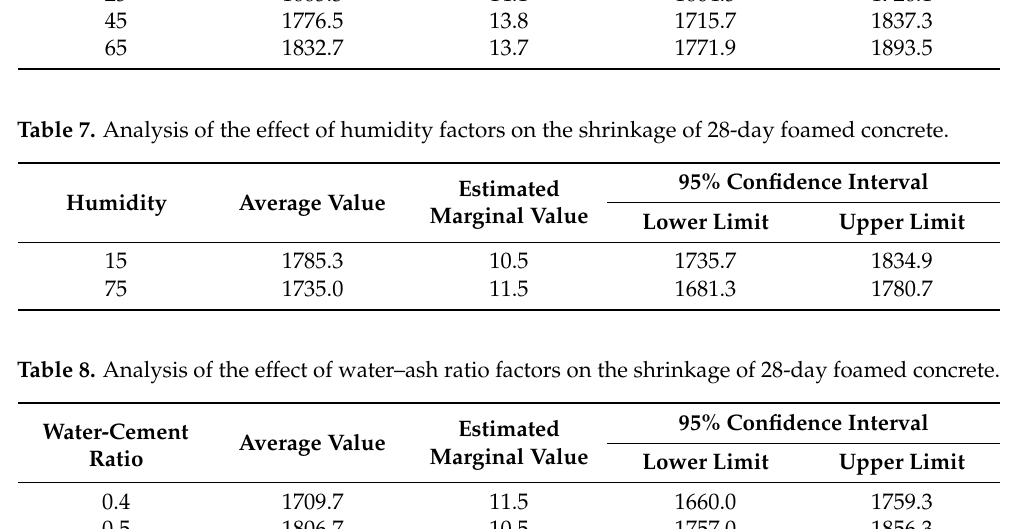
Table 6. Analysis of the effect of temperature on the shrinkage of 28-day foamed concrete. Temperature Average Value